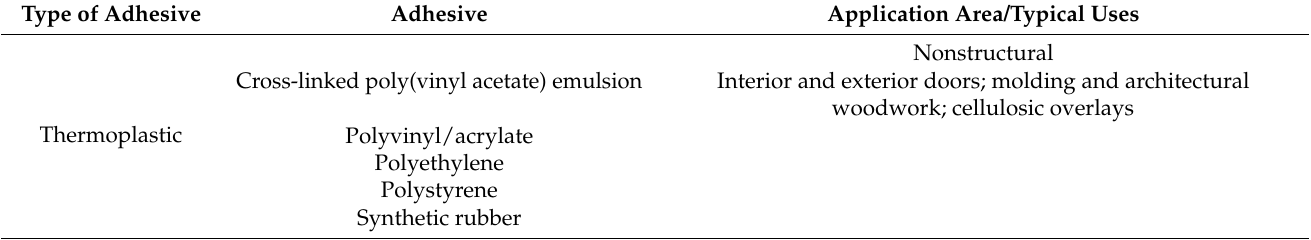
Table 1. Classification of adhesives used in EWPs and their general application area (adapted from